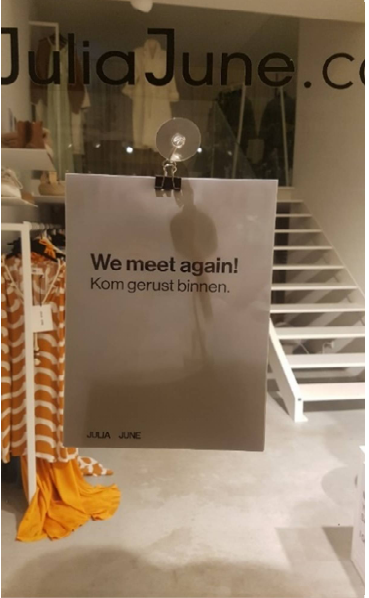
Figure 10. We meet again! Please do come in.